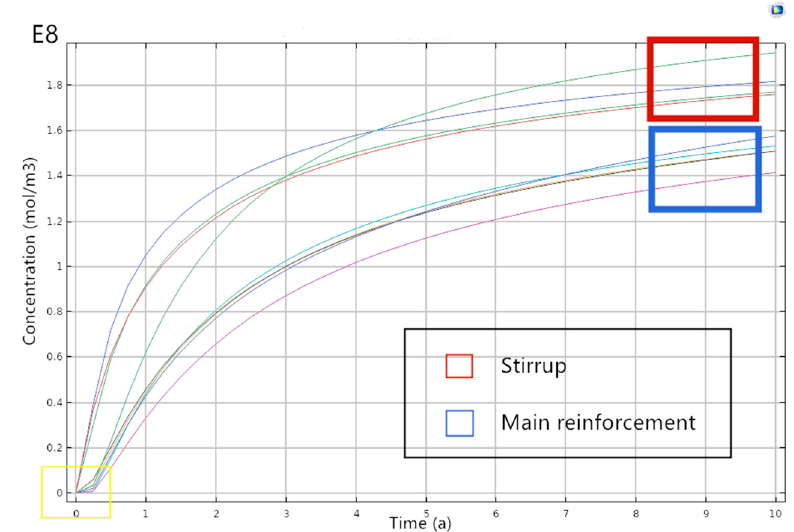
Figure 6. Curve of chloride ion concentration over time.